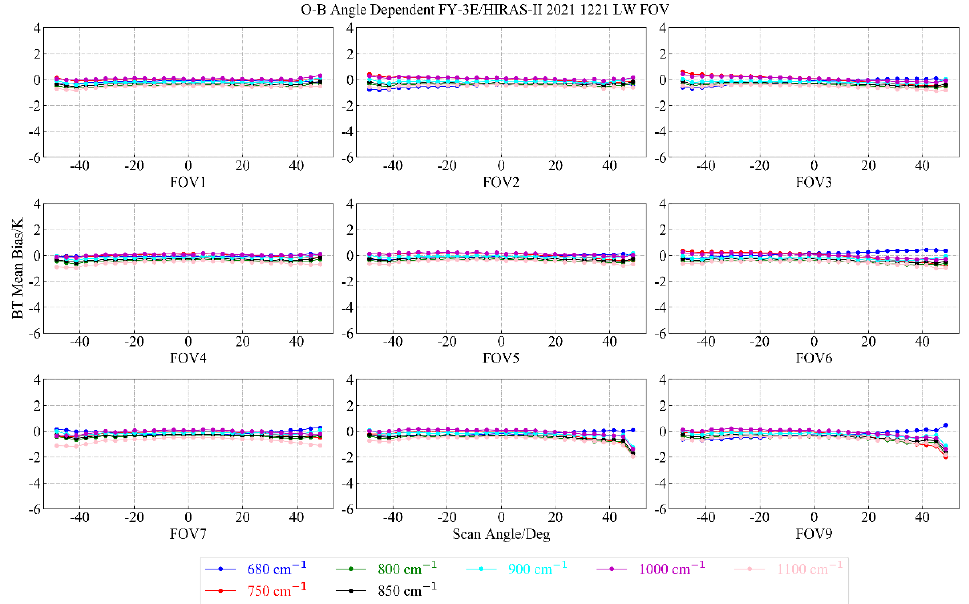
Figure 14. Distribution of mean bias of OMB values of 9 FOVs of typical long-wave channels as a function of scanning angle.